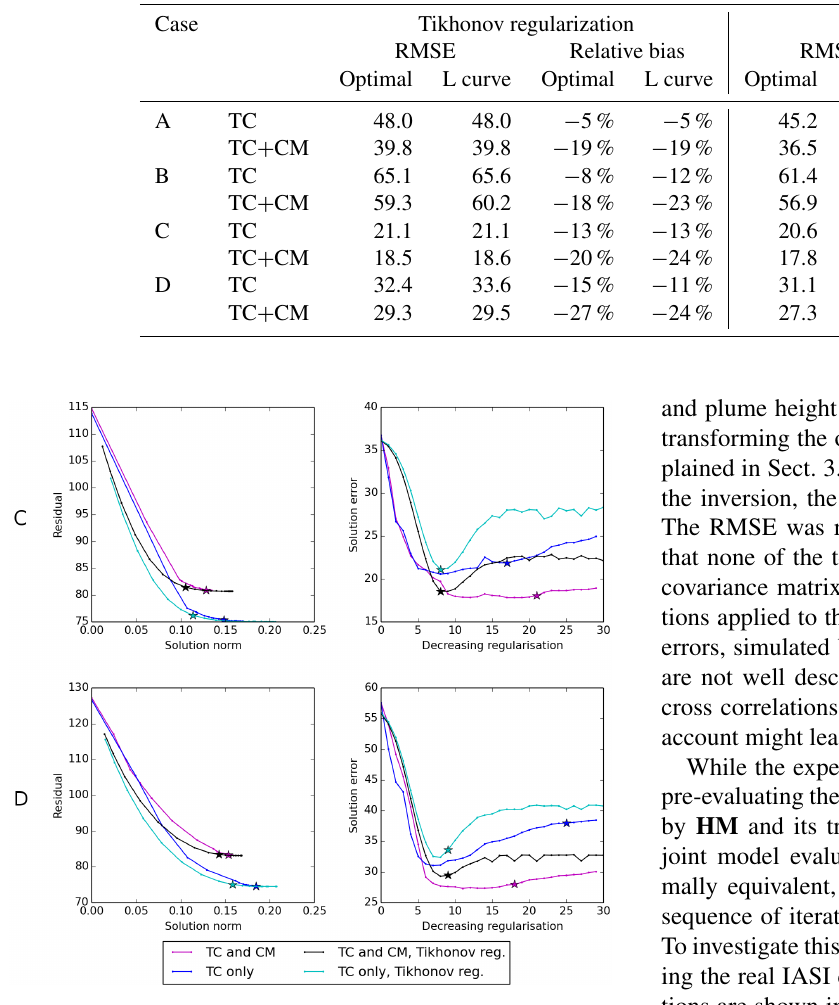
Figure 4. L curve (left) and rms error (right) for inversions with simulated data for cases C and D in Fig. 1. The iterate (for truncated iteration) or regularization parameter (for Tikhonov regularization) chosen from the L curve is marked with a